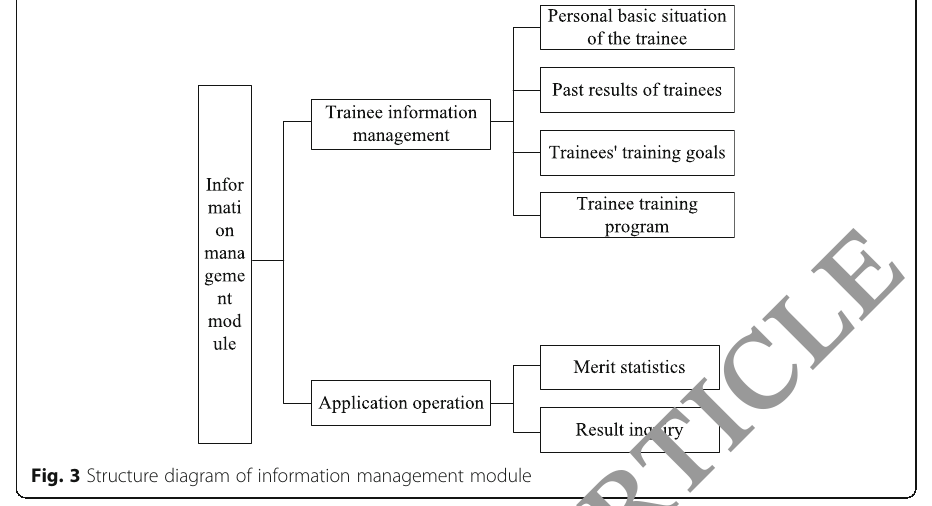
Fig. 3 Structure diagram of information management module